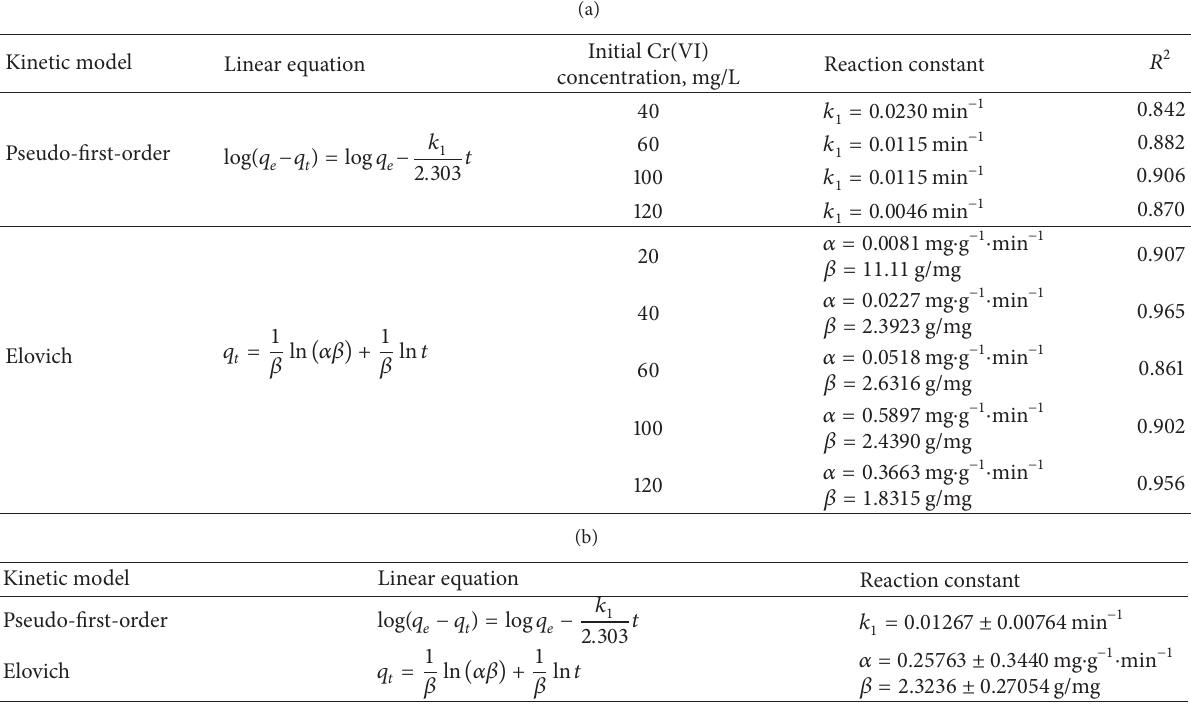
Table 2: (a) Kinetic parameters for the adsorption of Cr(VI) onto potato peel powder at 𝑇 = 27 ∘ C. (b) Averaged kinetic parameters for the adsorption of Cr(VI) onto potato peel powder at 𝑇 = 27 ∘